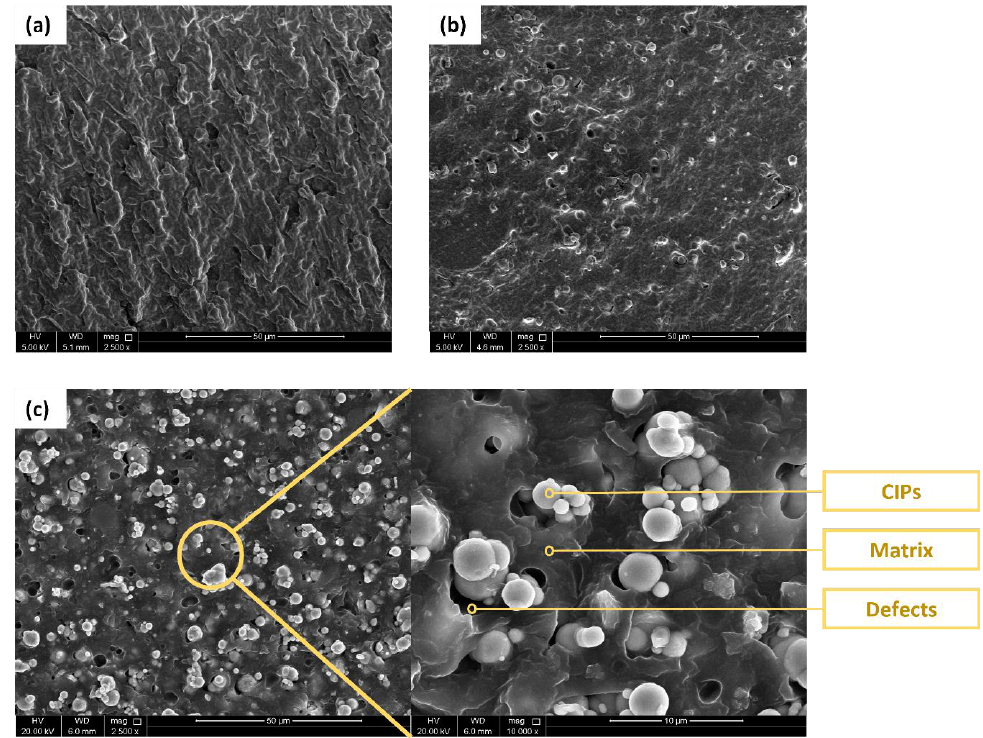
Figure 4. SEM images of isotropic MRE samples; ( a ) unfilled sample, ( b ) with 10% CIP volume fraction, and ( c ) with 20% CIP volume fraction.